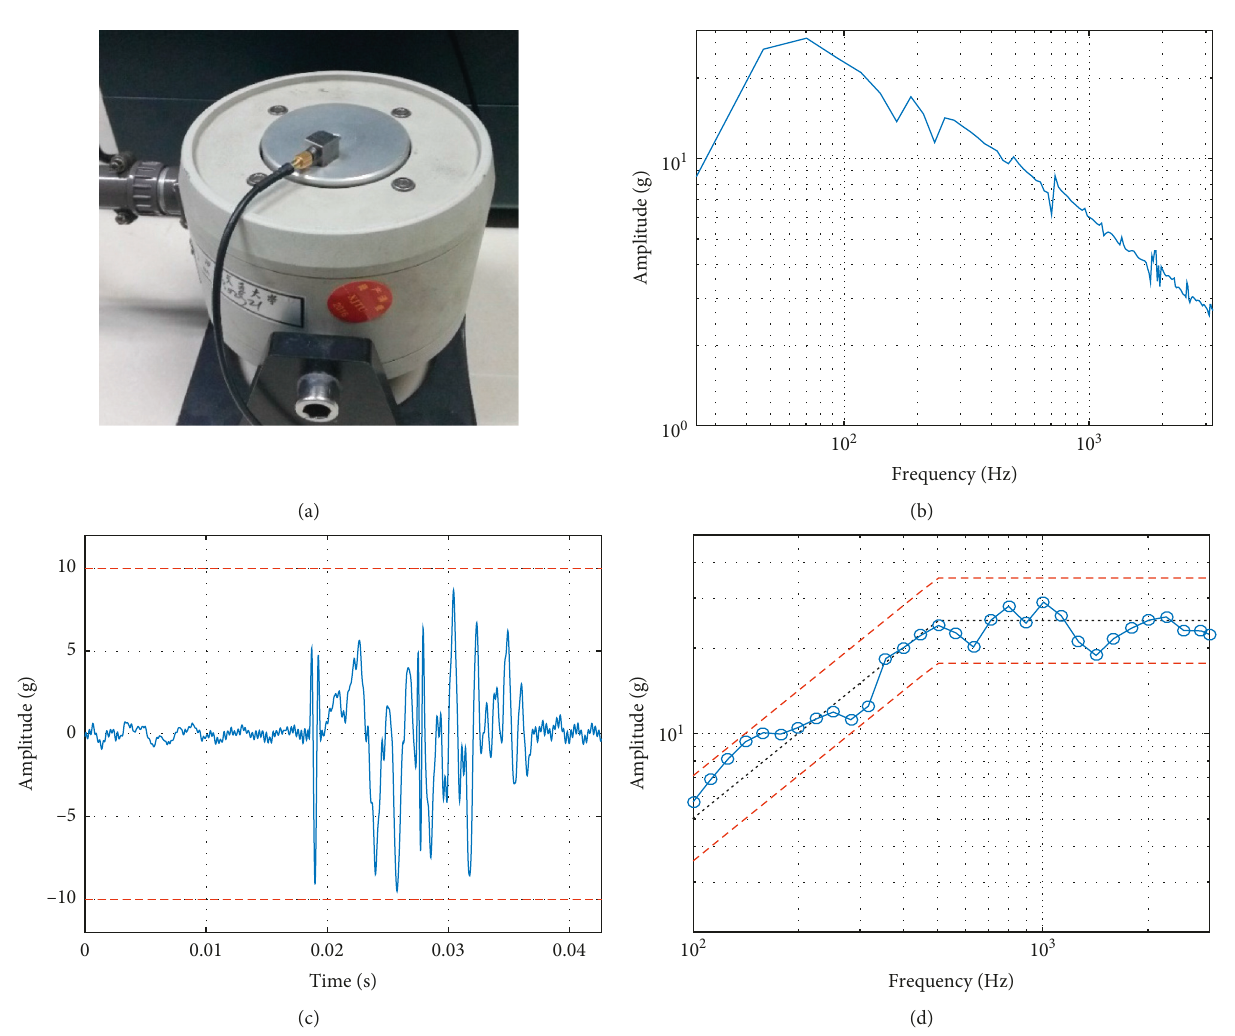
Figure 10: Case A: SRS experimental validation with no load. (a) Shaker; (b) FRF; (c) waveform; (d) SRS.